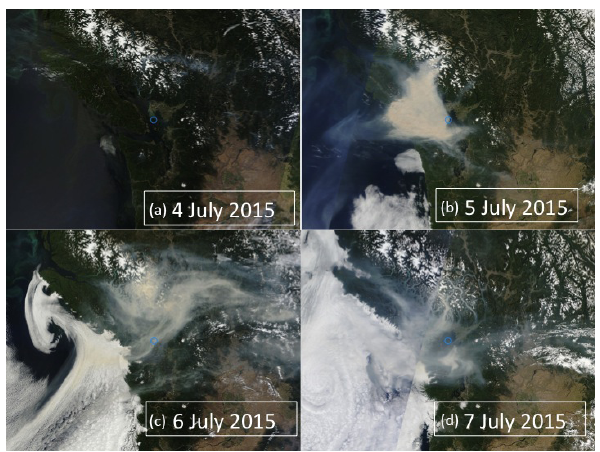
Figure 2. Modis satellite imagery for the period 4–7 July (Saturna Island shown in blue circle).